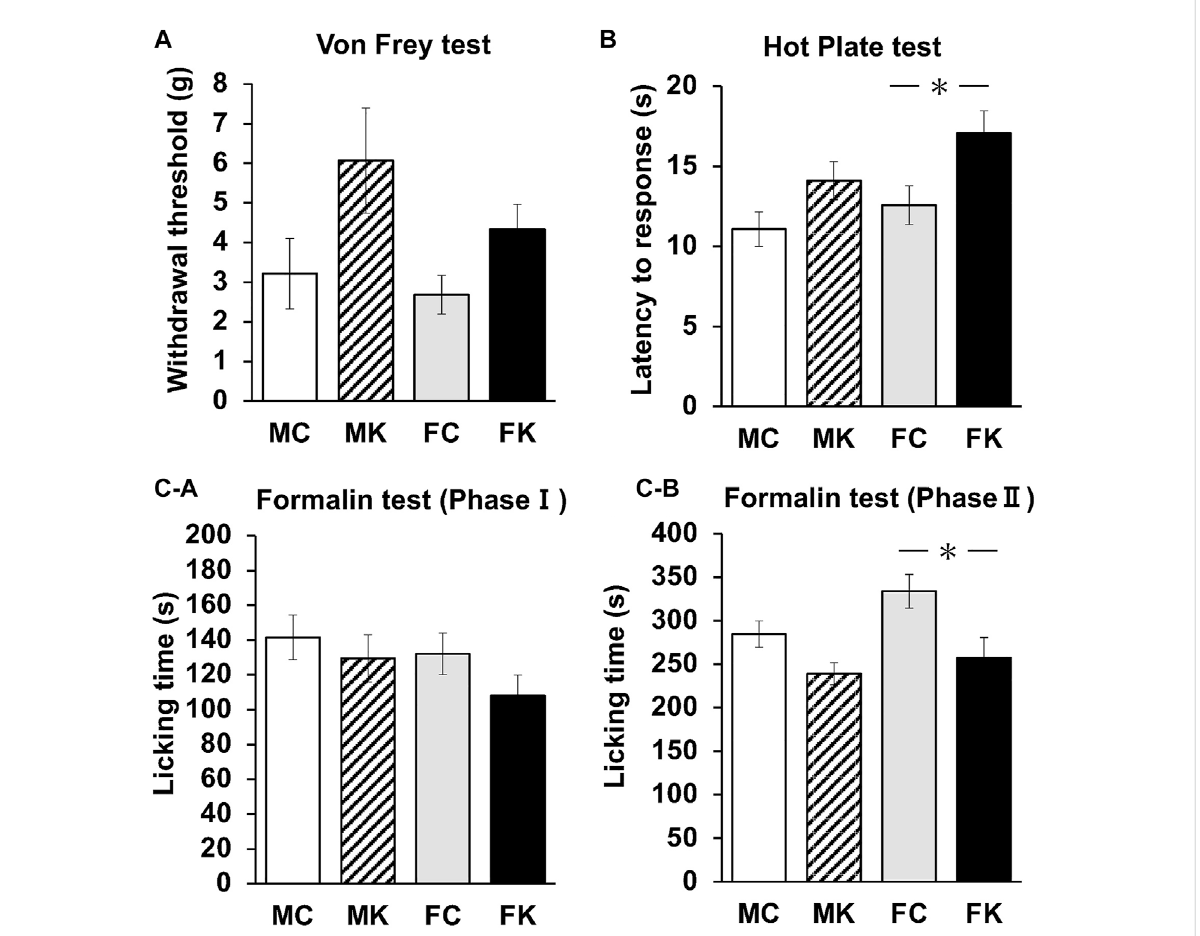
FIGURE 1 Changes in the mechanical nociceptive threshold as measured by von Frey (A) and hot plate (B) tests of the male control group (MC), male Kamikihi-to (KKT)-treated group (MK), female control group (FC) and female KKT-treated group (FK) ( n = 12 per group at each test). The time course of the development of the formalin response (i.e., licking time) was measured. (C-a) Phase I (0 – 10 min after subcutaneous injection of 2% formalin) andphaseII(10 – 40 minaftersubcutaneousinjectionofformalin)werecalculated (C-b) .Thedataarepresentedasthemean±standarderrorof the mean. * p < 0.05 compared between the control and KKT